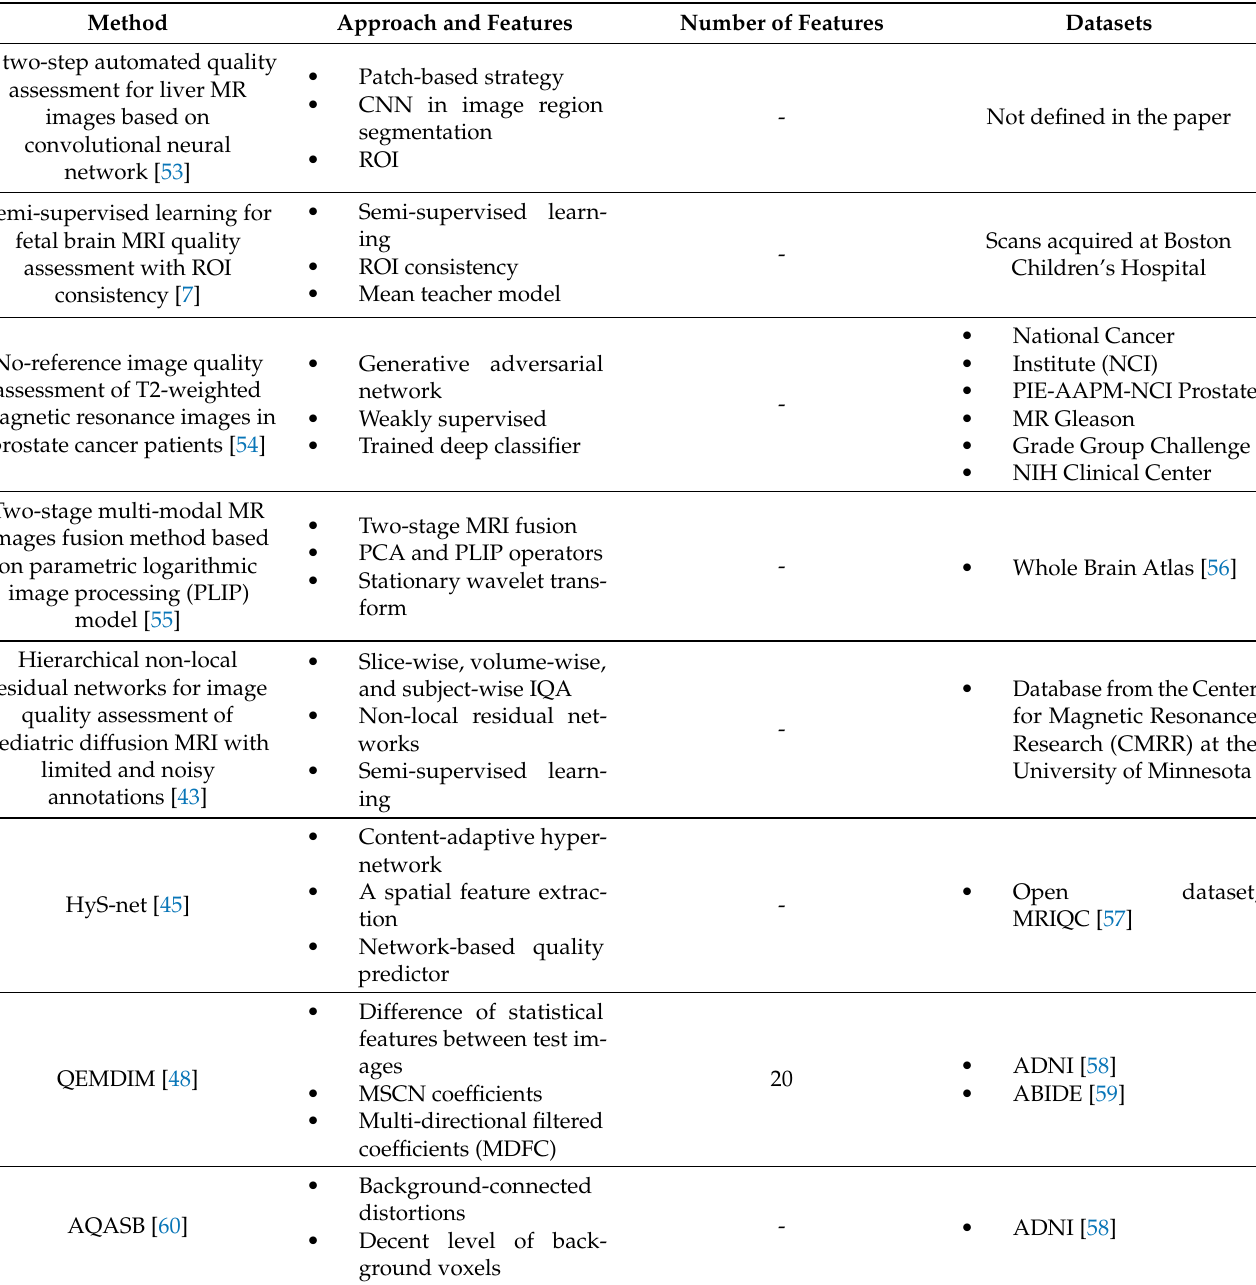
Table 1. Comparison of NR-IQA methods in terms of employed techniques, features, and used